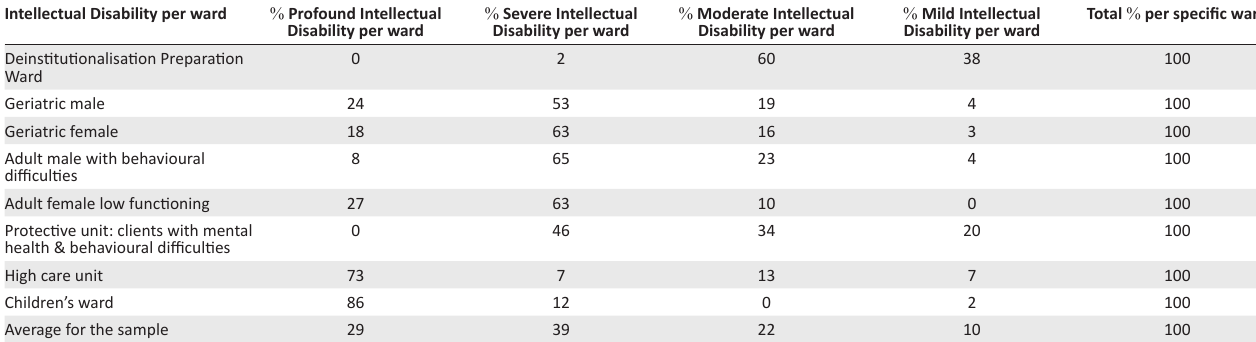
TABLE 3: Frequency of levels of intellectual disability n = 568. Intellectual Disability per